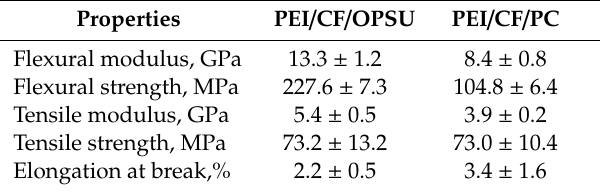
Table 8. Mechanical properties of the printed composites based on PEI / CF with OPSU and